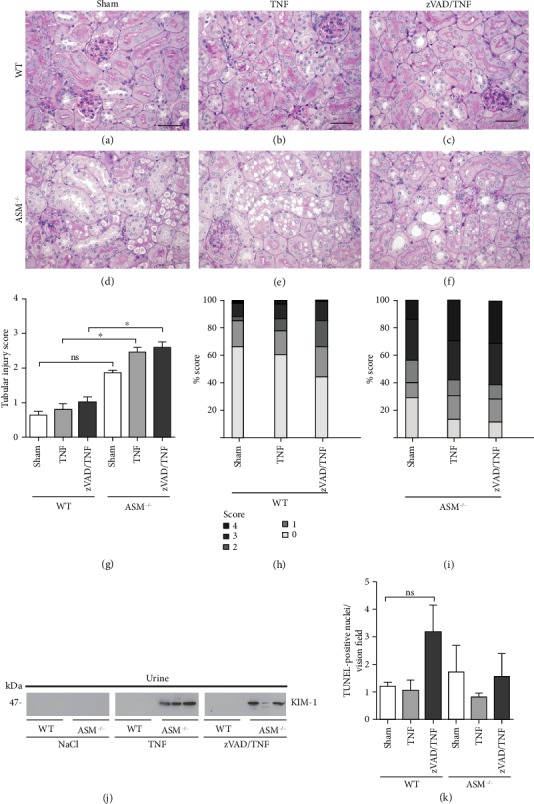
Kidney injury. Representative PAS-stained kidney sections from (a–c) WT mice and (d–f) ASM−/− mice treated as indicated above; scale bars 50 μm, magnification 400x. (g) The total tubular injury score. The tubular injury was scored in (h) WT and (i) ASM−/− mice on a scale of 0–4: 0 = normal histology, 1 = mild dilatation, 2 = flattened epithelial cells and loss of brush border, 3 = mild vacuolization of tubular cytoplasm (<5 vacuoles/tubule) and tubular cell necrosis/apoptosis; 4 = strong vacuolization of tubular cytoplasm (>5 vacuoles/tubule) and tubular cell necrosis/apoptosis. (j) The tubular injury marker KIM-1 was analyzed in urine samples by western blot. Data are shown as mean + SEM with n = 5 in all groups except for ASM−/− sham with n = 6. (k) TUNEL staining of representative kidney sections. ns: not significant, ∗p < 0.05.